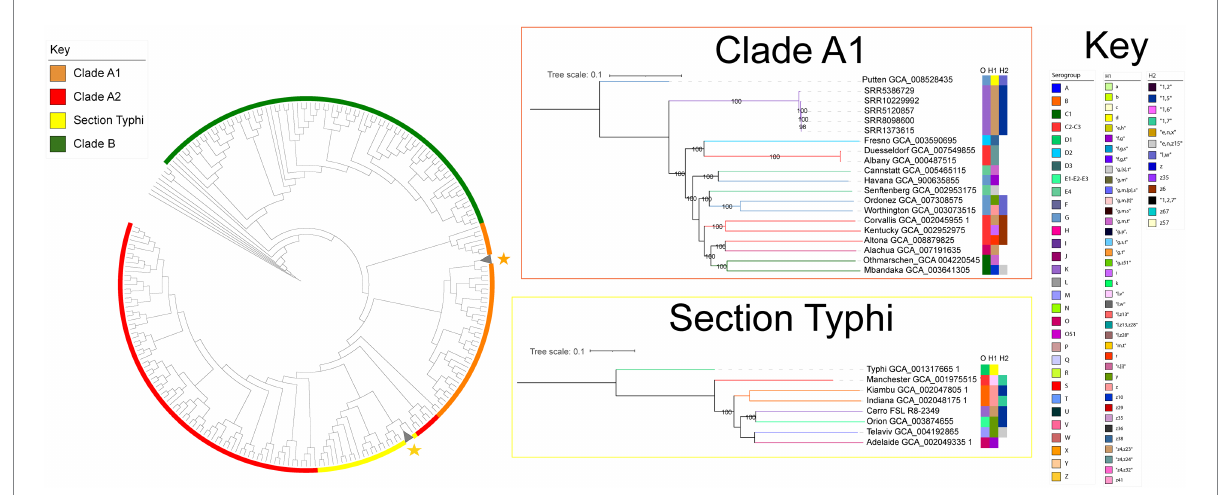
FIGURE 1 S. Cerro is polyphyletic and the majority of isolates cluster within the Salmonella section Typhi lineage. Maximum likelihood phylogenetic tree constructed from 12,238 core SNPs for representative isolates of S. Cerro and isolates representing 235 S. enterica subsp. enterica serovars and five Salmonella subspecies (Gaballa et al., 2021); branch lengths are not shown. Clade designations shown are based on those defined previously (Worley et al., 2018). Salmonella enterica subsp. arizonae was used as an outgroup to root the phylogeny. Maximum likelihood trees of the sub- clades in which S. Cerro isolates cluster are also shown. The Clade A1 tree was constructed from 60,135 core SNPs and the section Typhi tree was constructed from 46,278 core SNPs. Phylogenies are rooted by outgroup (the clade A1 phylogeny uses S. Putten GCA_008528435 as an outgroup, the section Typhi phylogeny uses S. Typhi GCA_001317665.1 as an outgroup; bootstrap values represent the average of 1,000 bootstrap